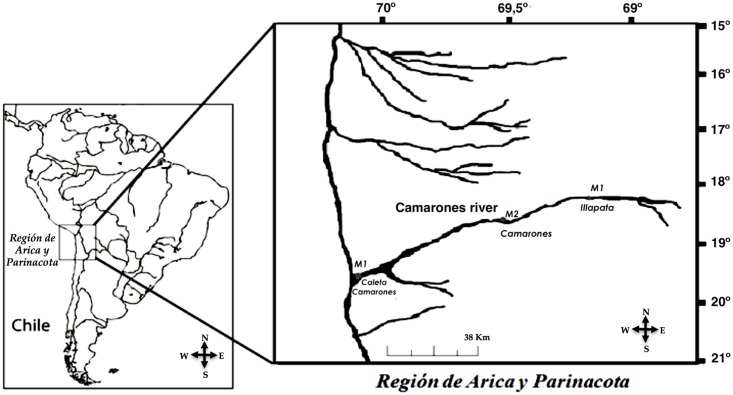
Map of the Chilean Arica y Parinacota region and location of M1, M2 and M3 sampling sites along the Camarones River.